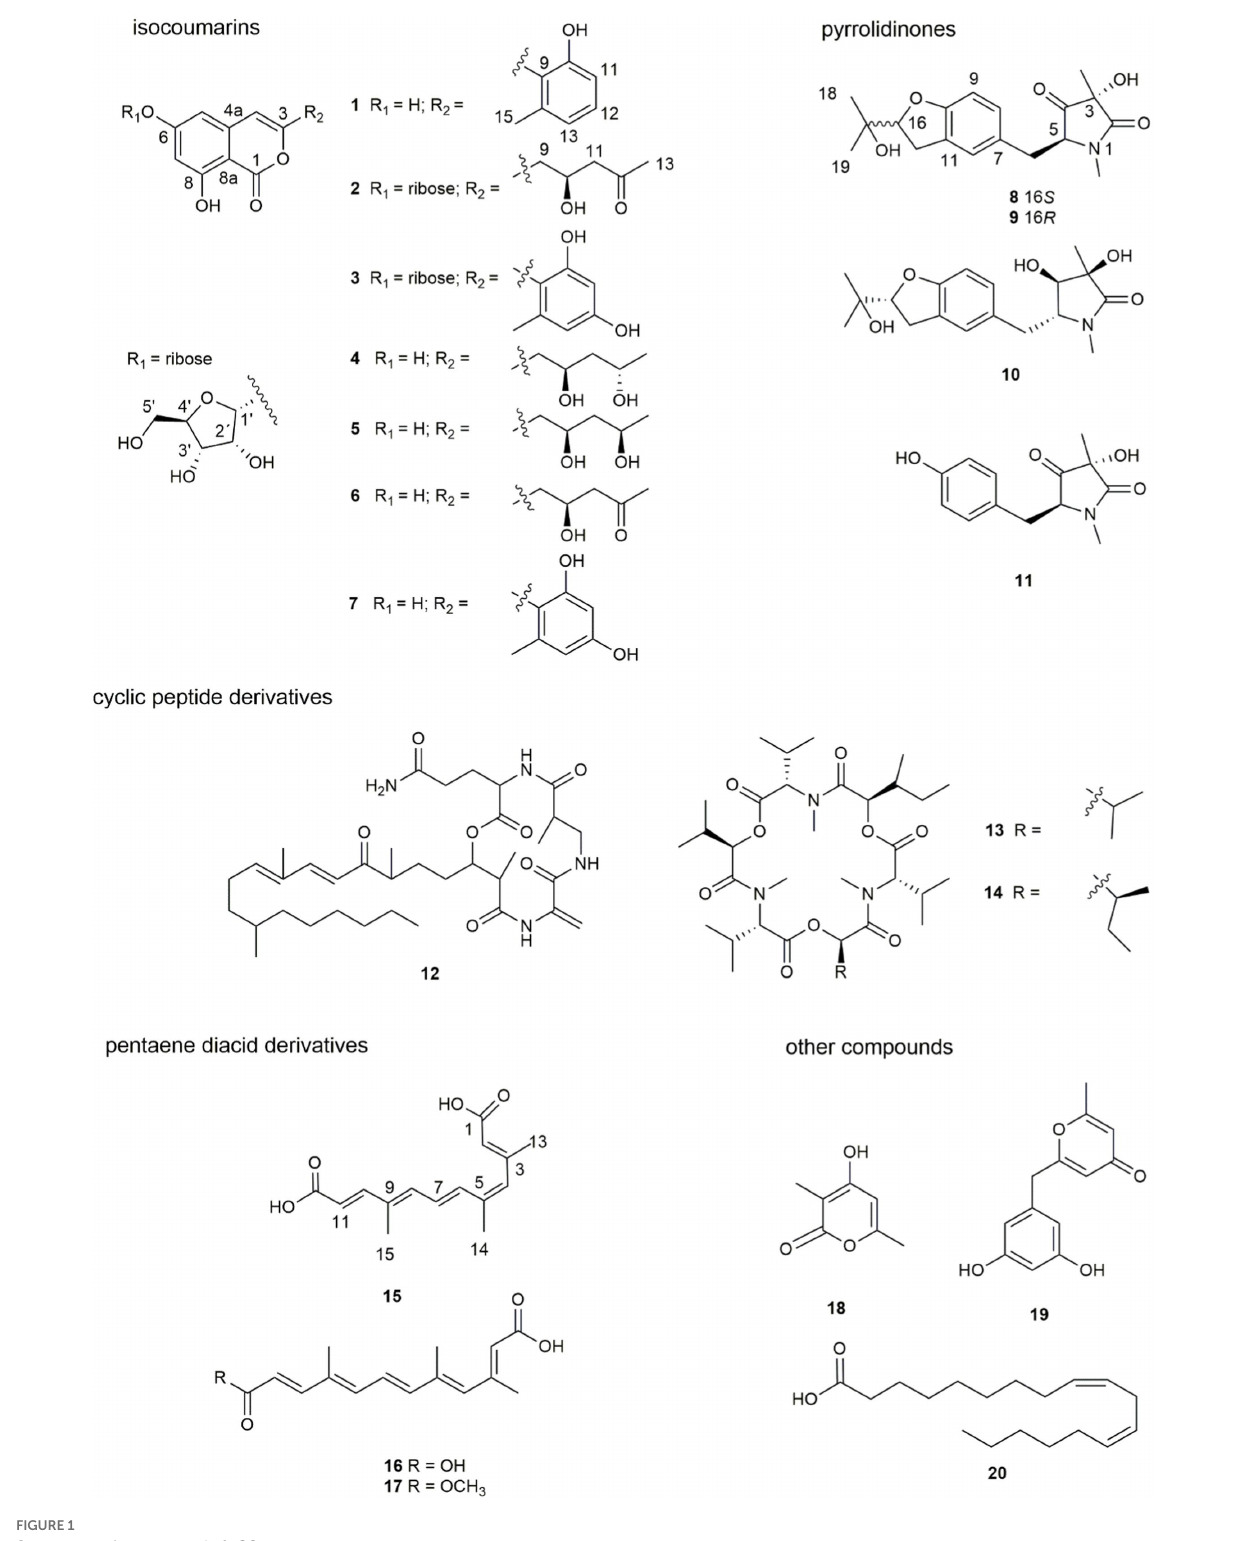
Table 1; HRESIMS m/z 285.0762 [M + H] + (calcd. For C 16 H 13 O 5 , 285.0757).